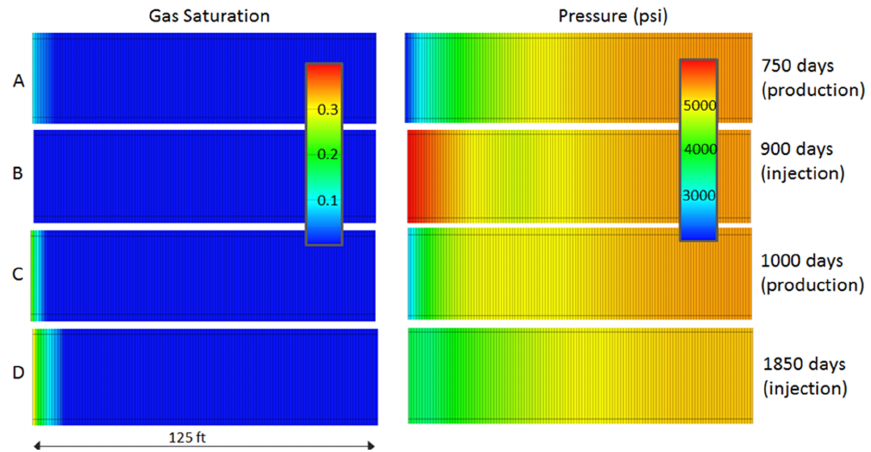
Figure 10. Gas saturation and pressure distribution for the quarter-fracture model at various times of production and injection during the hu ff -n-pu ff